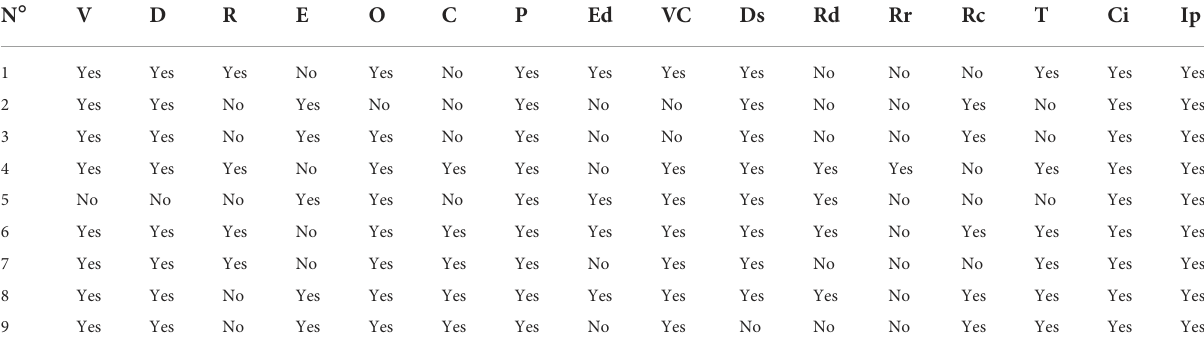
TABLE 3 Summary of analysis of selected studies. N